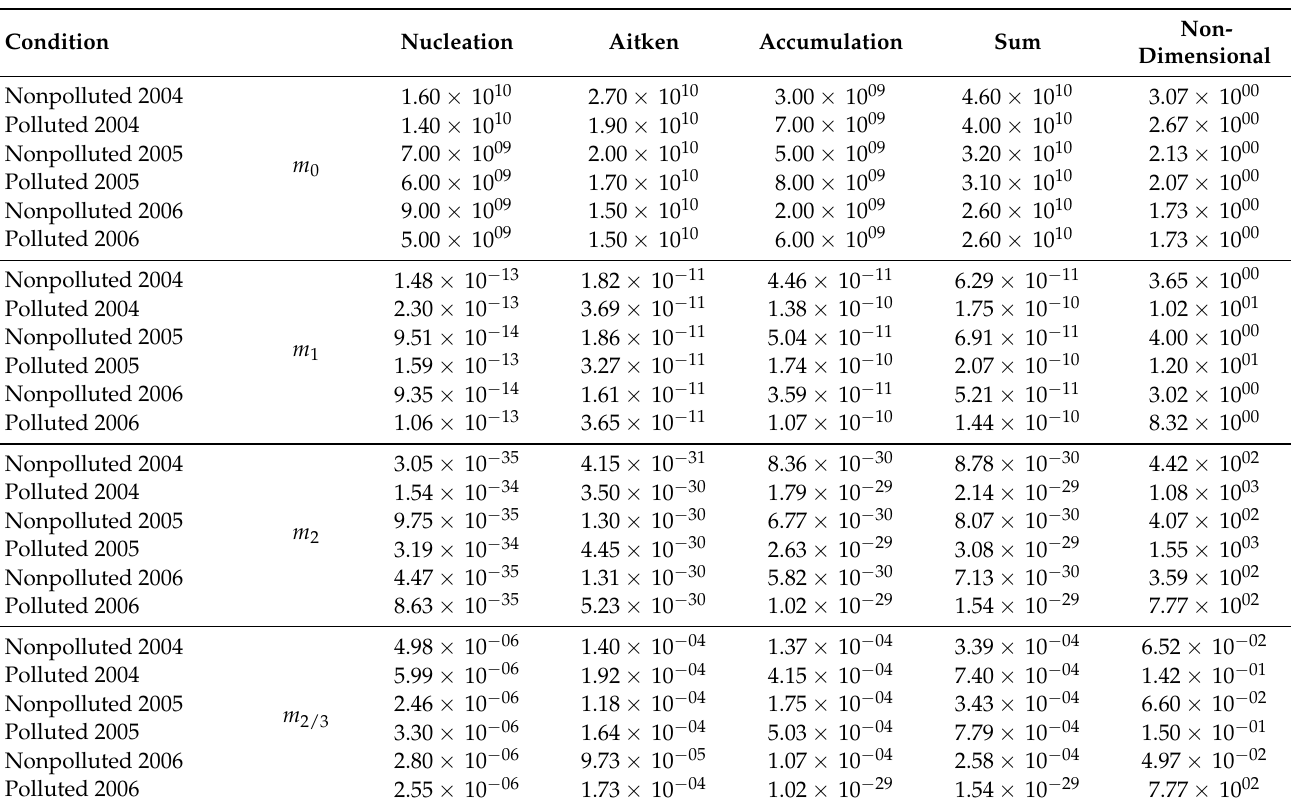
Table 2. Initial moments of 2004, 2005, and